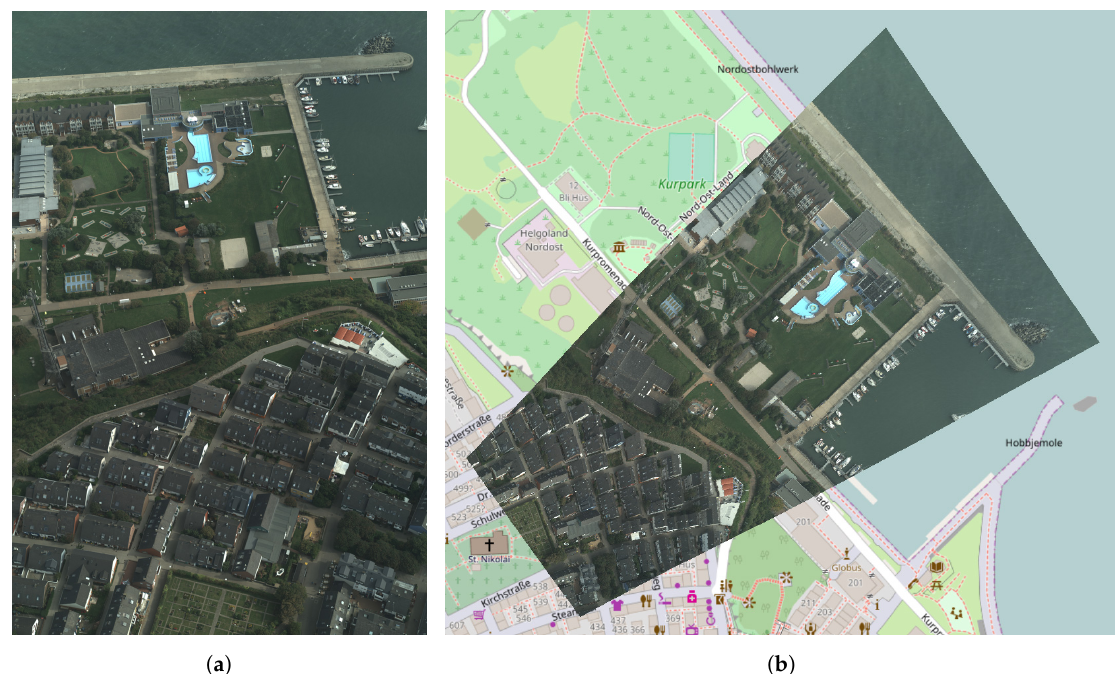
Figure 9. Projective mapping: Single aerial image ( a ) and its perspective projection ( b ) by application of the corresponding transformation